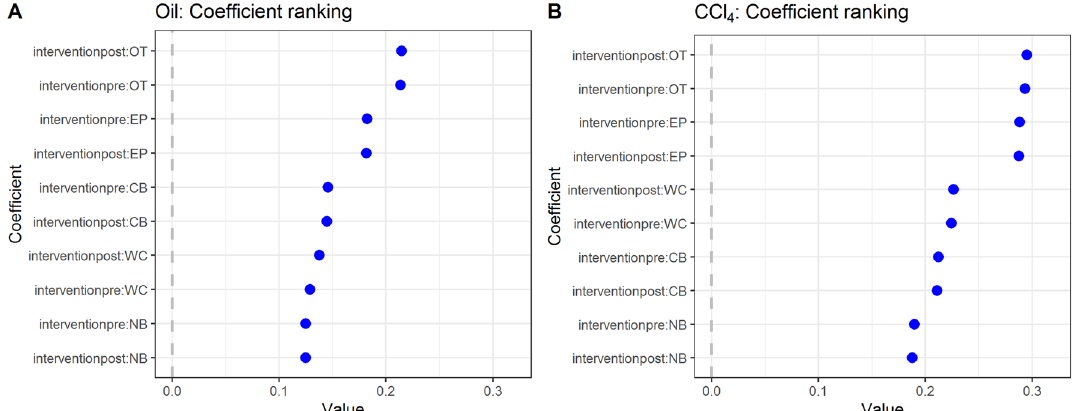
Figure 2. Time-independent regression coefficients of the penalized least square regression, ordered by magnitude. The coefficients describe the relationship between the predictor variables and the response (MGS). Larger coefficients have more weight in the regression model and are deemed more important. ( A ) In the control group, the orbital tightening parameter shows the largest and nose bulge the lowest coefficients. ( B ) In the CCl 4 group, all coefficients have higher values, and, orbital tightening is also the highest-ranking coefficient found by the model. Nose bulge performed worst.